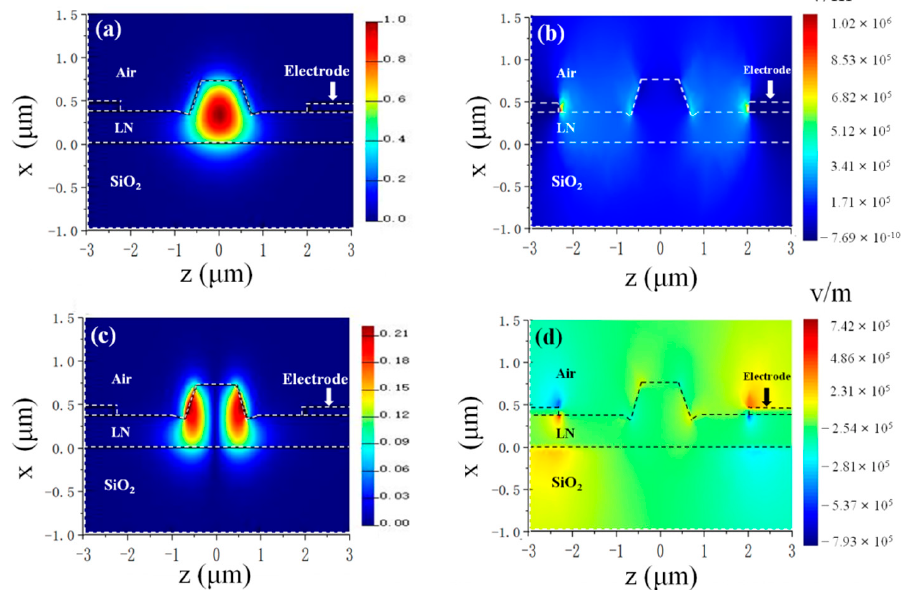
Figure 7. SEM image of phase modulator in grinded LNOI ( a ) and cross-section AFM image of LNOI waveguide ( b ). Simulated electric field distributions of the TE 00 ( c ) and TE 10 mode ( d ) in LN waveguide.